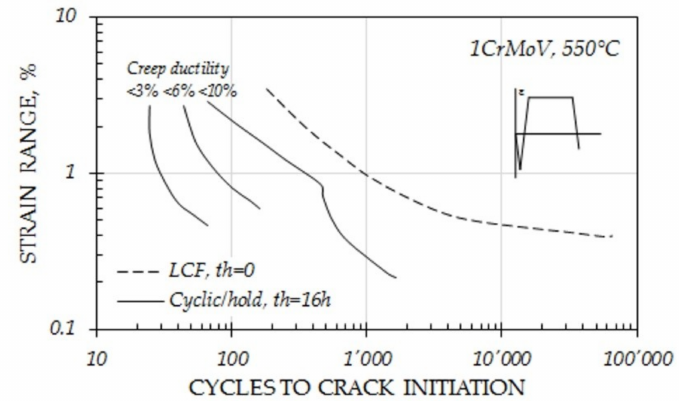
Figure 9. Influence of creep ductility on cyclic/hold creep-fatigue crack initiation